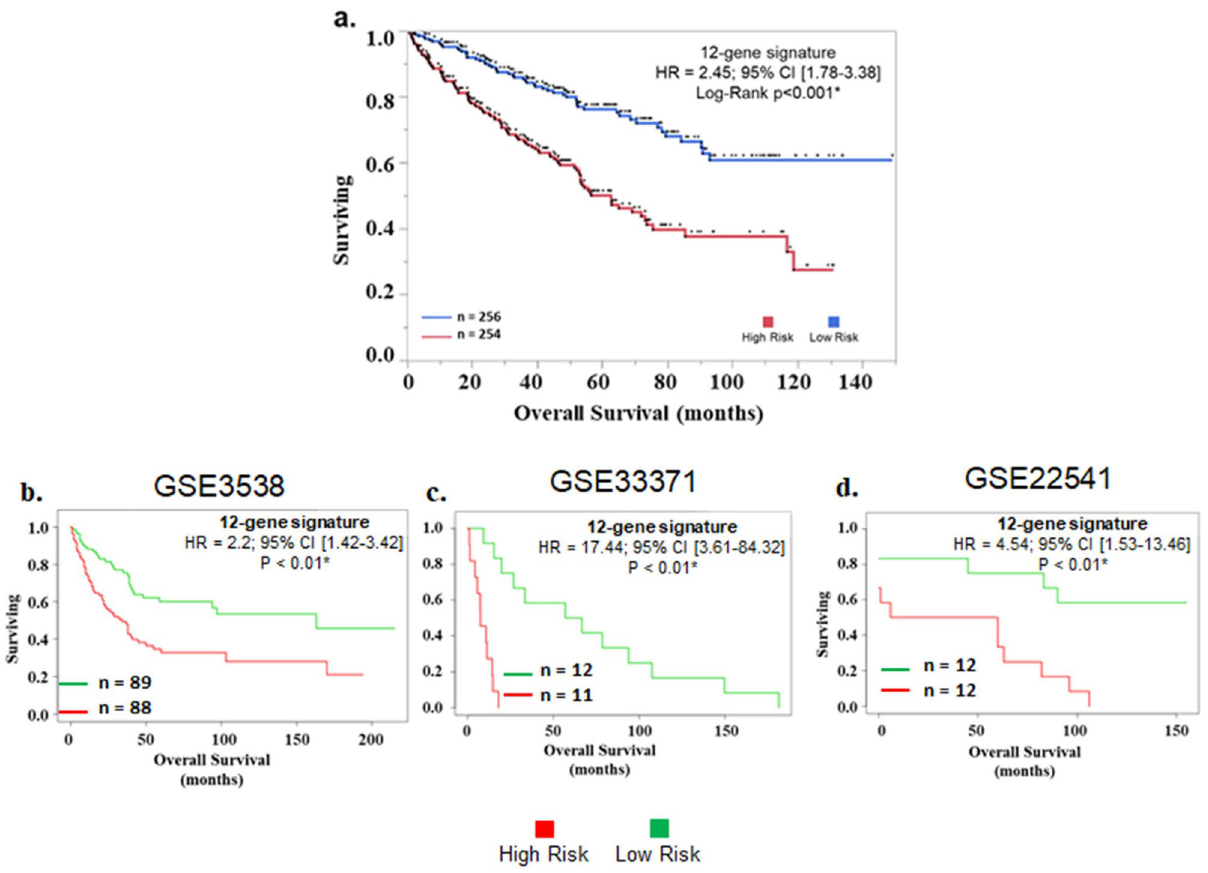
Figure 5. Survival analysis of 12 gene signature with kidney renal cell cancer patients in ( a ) TCGA dataset, ( b ) GSE3538, ( c ) GSE33371, and ( d ) GSE22541. Patients were divided using median risk-score value as cut-off dividing in high-risk and low-risk subgroups.